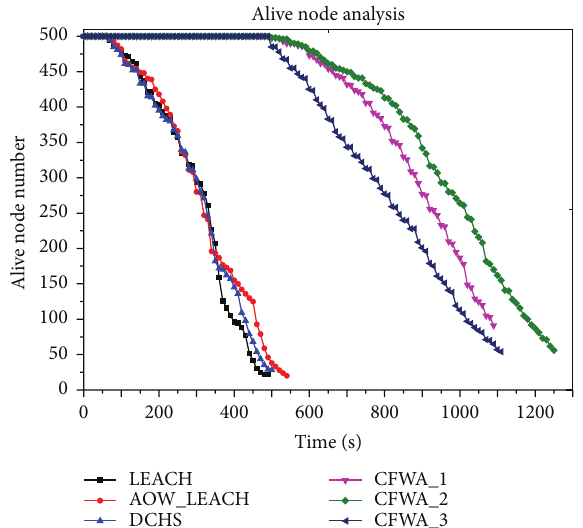
Figure 11: Alive nodes comparison diagram between CFWA family algorithms and LEACH-like algorithms in 500 nodes.